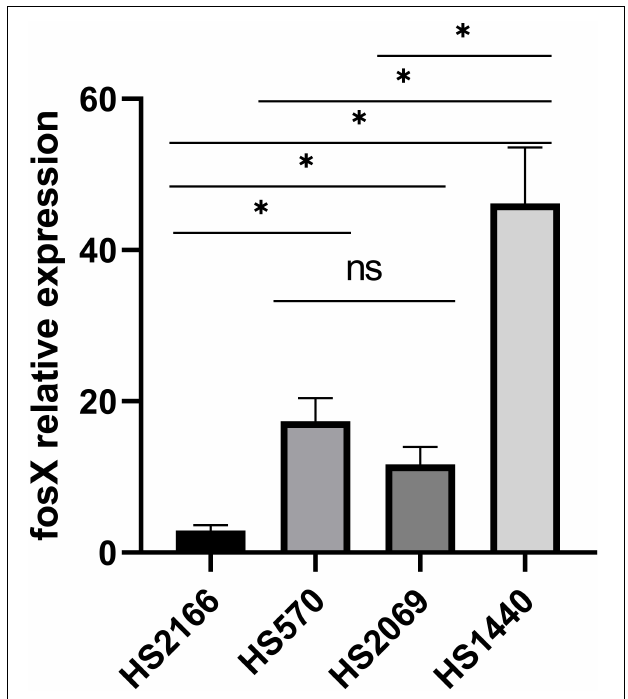
FIGURE 2 | The relative expression of fos X gene in HS2166, HS570, HS2069, and